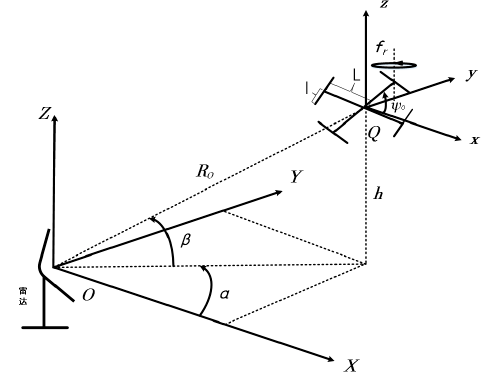
Figure 2. The geometry of the quad rotary-wings and the radar.